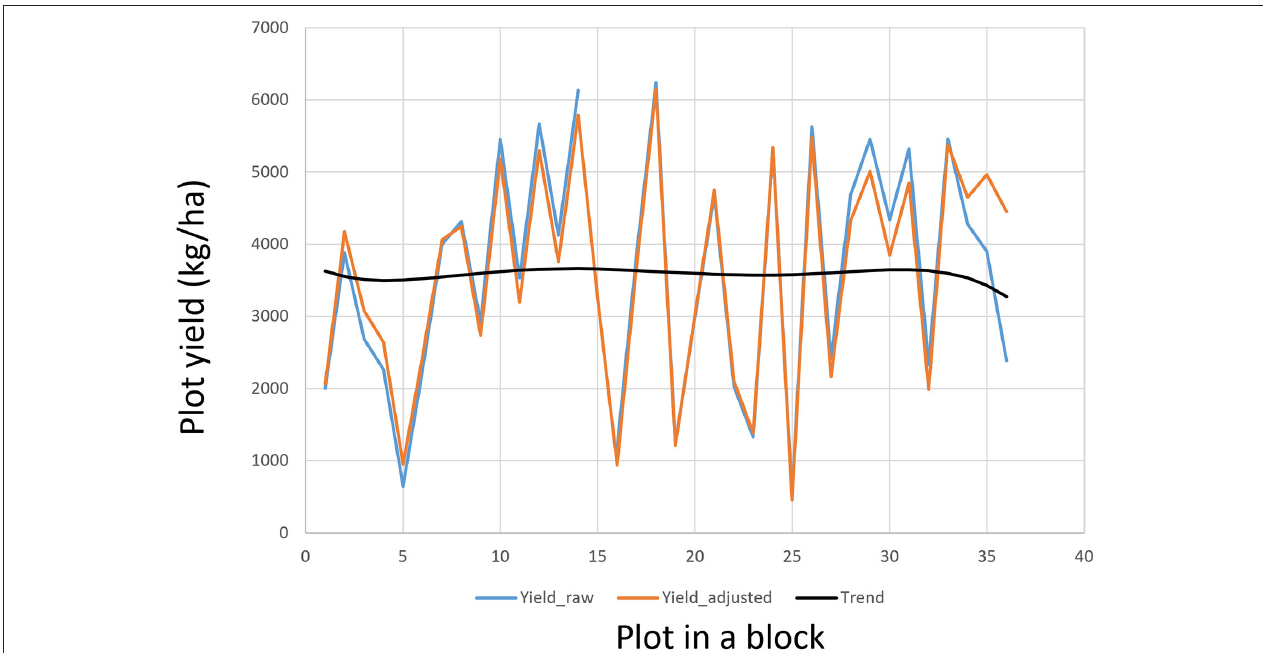
FIGURE 8 | An example to show the plot values within a block as adjusted according to the field trend modeled by a polynomial regression.